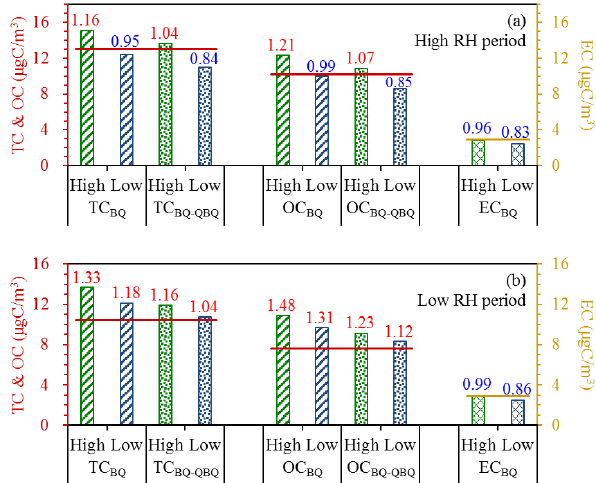
Figure 4. Comparison of the 48h averaged TC, OC and EC con- centrations measured by different sampling configurations and fre- quencies during the high RH (a) and low RH (b) periods. In the title of each horizontal axis, “High” and “Low” indicate results from the high- and low-frequency samples, respectively. The horizontal lines correspond to the reference values, which are derived from the high- frequency denuded filters (i.e., DQ). The bars indicate the alterna- tive estimations. The values above each bar are the average of the alternative-to-reference ratios, while the red and blue fonts indicate an overestimation and underestimation, respectively. The difference between the high-frequency EC BQ and the reference value (i.e., the high-frequency EC DQ ) is not significant at a 95% level of confi- dence (two-tailed p = 0 . 113), whereas the difference between the low-frequency EC BQ and the reference value is significant (two- tailed p = 0 . 000). Scatter plots describing the comparisons shown in this figure are provided in the